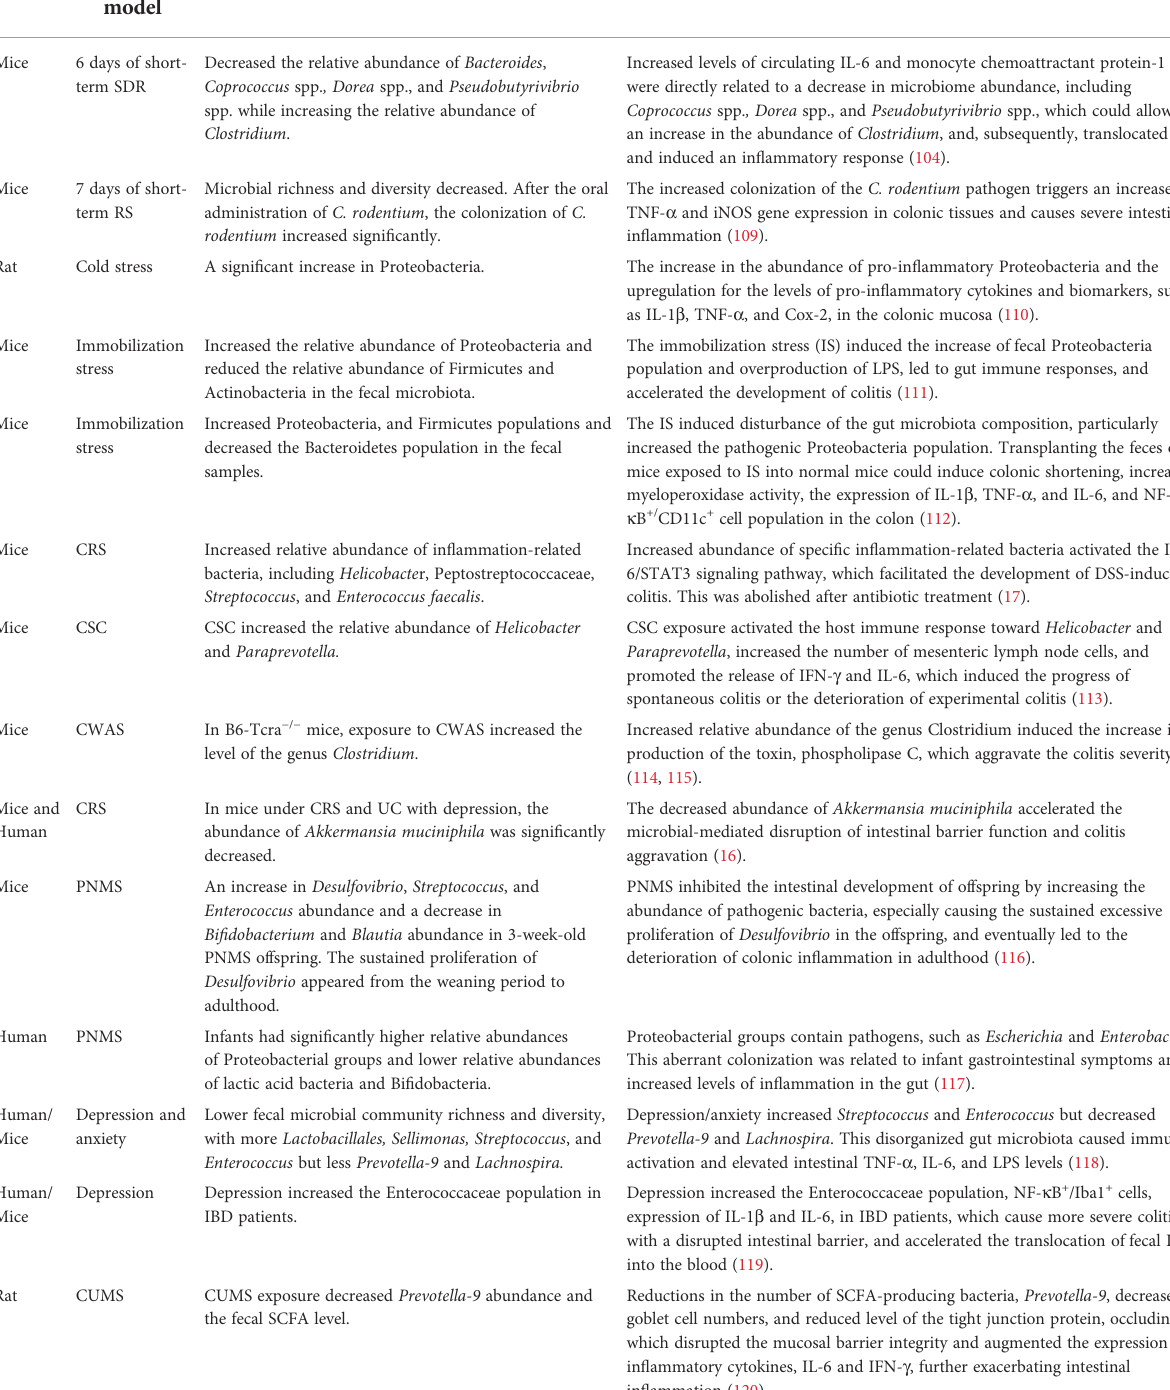
TABLE 2 Stress-induced microbiota dysbiosis and mechanism promoting IBD/in fl ammatory aggravation. Species Stress Stress-induced microbiota dysbiosis model